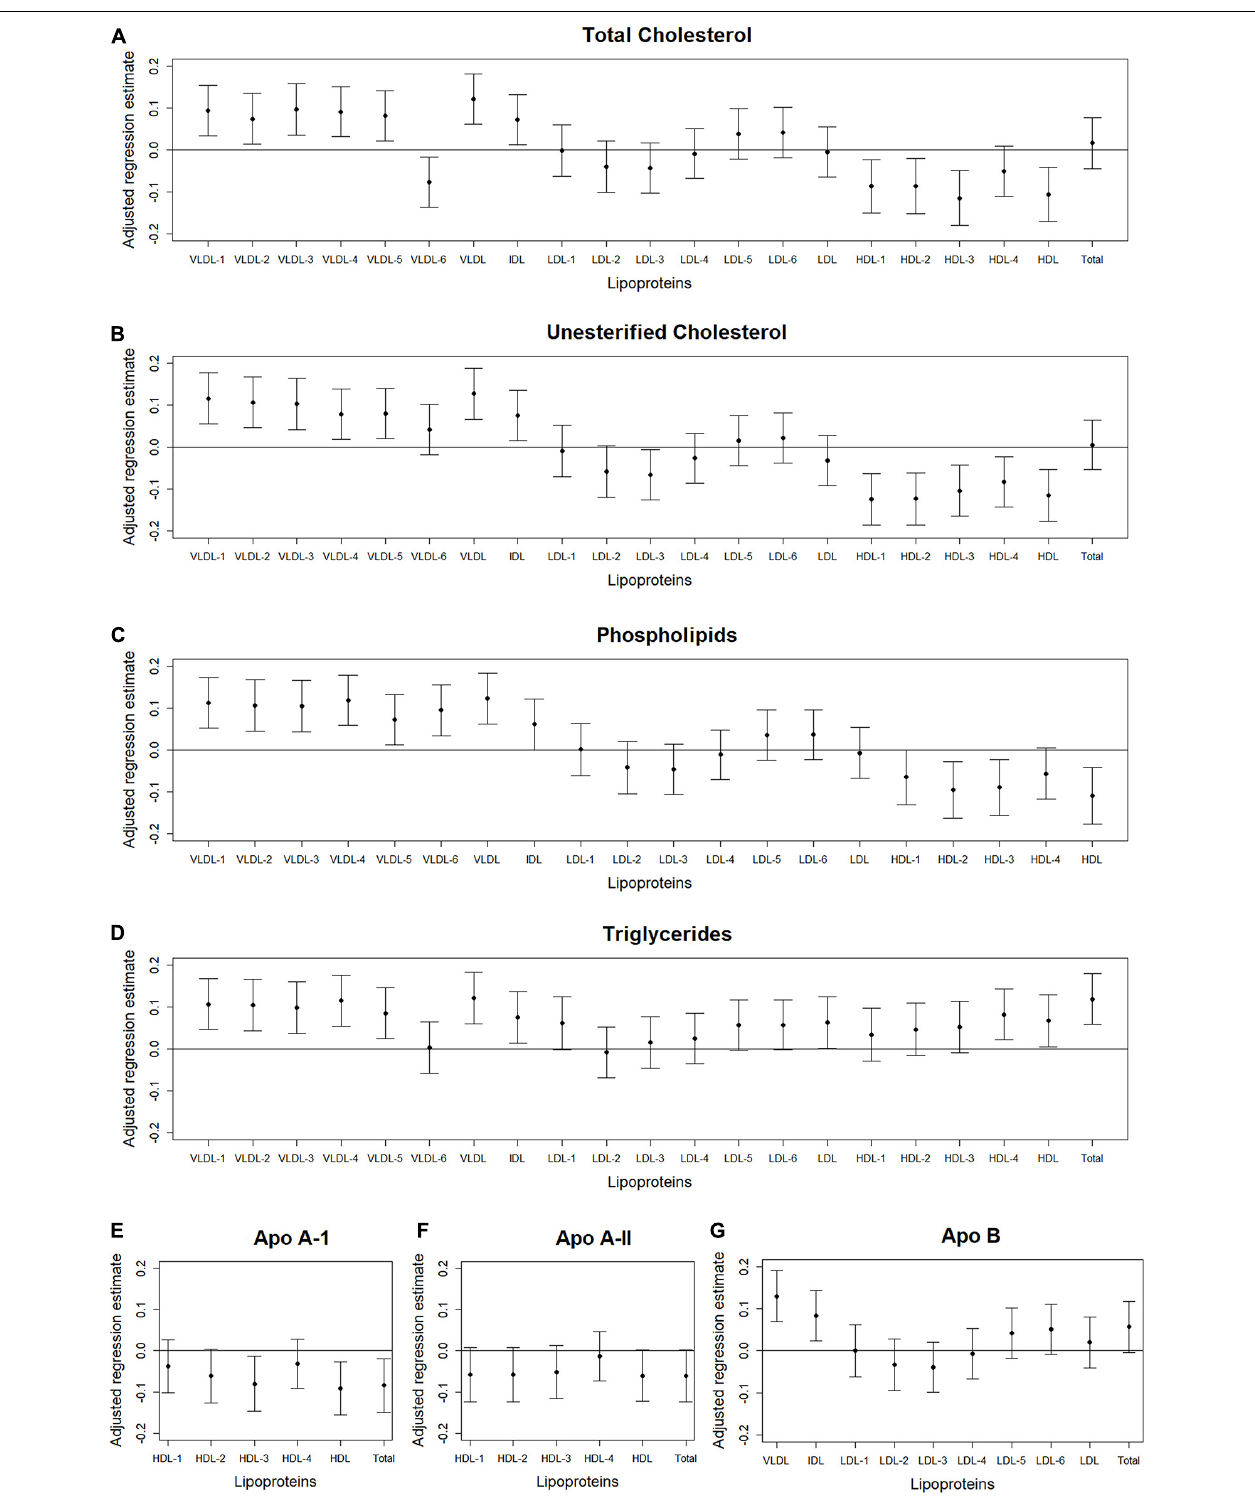
FIGURE 3 | Total abdominal IMAT area: Scatterplots of the adjusted associations between 105 lipoprotein subfractions and IMAT area ordered from lowest to highest density lipoprotein subfraction and by total cholesterol (A) , unesterified cholesterol (B) , phospholipids (C) , triglycerides (D) , apo A-I (E) , apo A-II (F) , and apo B (G) among 947 MESA